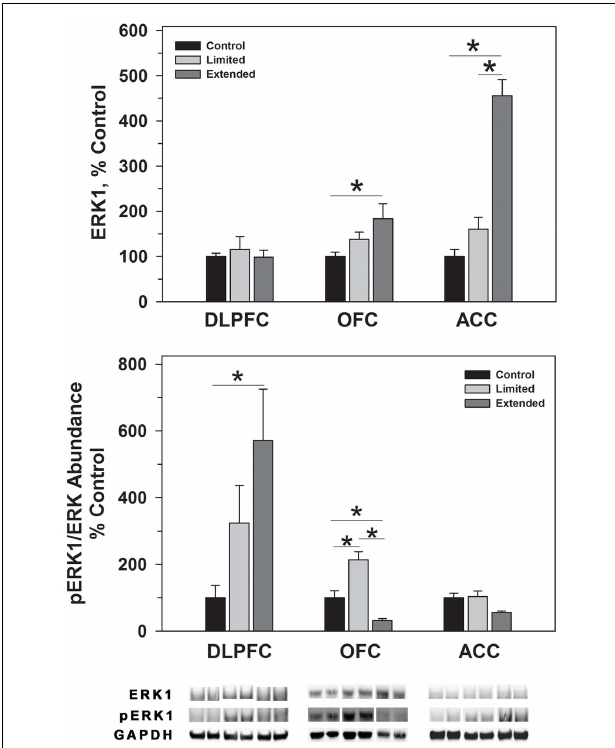
FIGURE 4 | Protein levels of ERK2 and pERK2 in prefrontal regions following limited and extended access to cocaine self-administration . Cytosolic fractions were isolated as described in the Section “Materials and Methods” and 10 µ g were separated on 10% SDS-PAGE. Data are expressed as mean ( ± SEM) of the percent of control values per amount of protein loaded. Asterisks indicate a significant difference ( P < 0.05). Bottom Panel: Representative bands from two subjects per group per